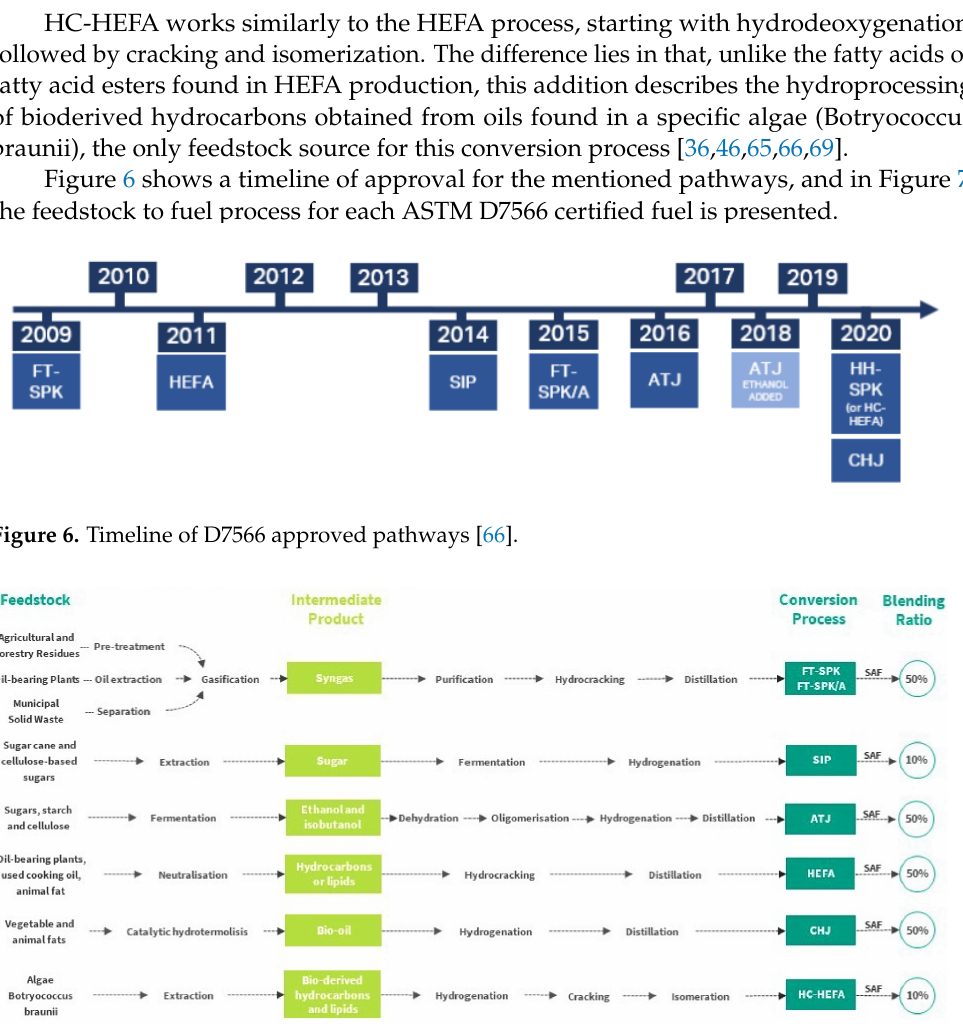
Figure 7. Feedstock to fuel process for D7566 approved pathways [46]. Source: PtX Hub (2021). All rights